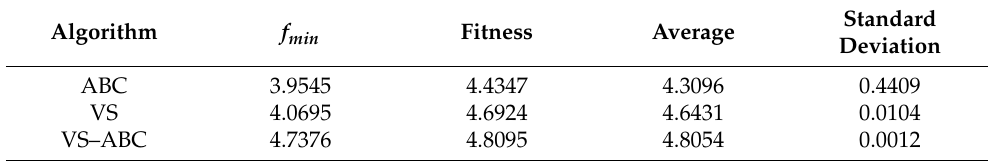
Table 13. The numerical results of Sphere.